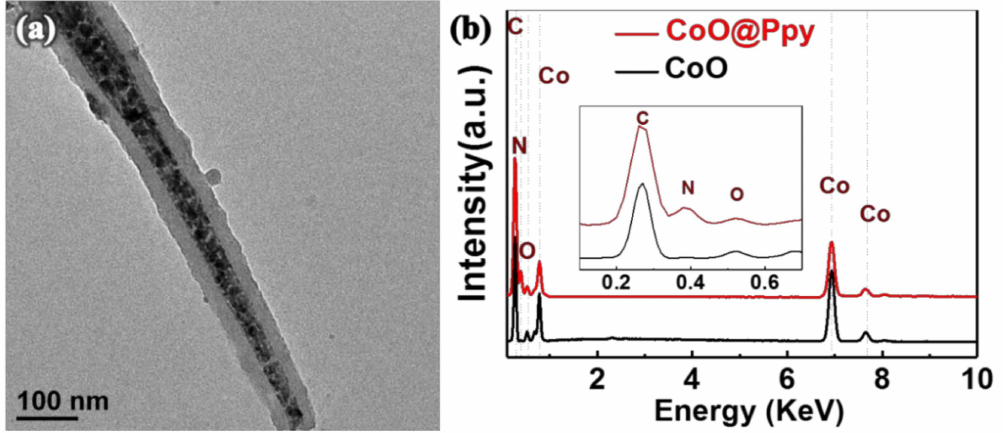
Figure 2. ( a ) Transmission electron microscopy (TEM) characterization and ( b ) energy dispersive X-ray spectrometer (EDX) results of core-shell CoO@Ppy